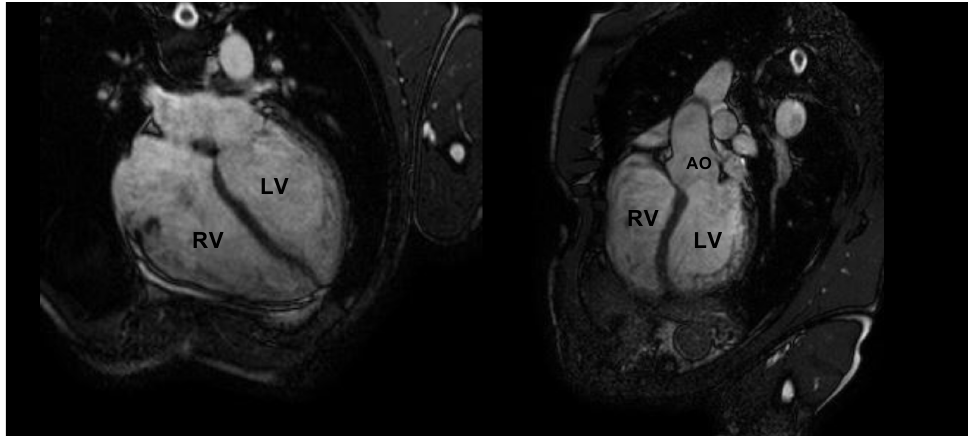
Figure 4. Cardiac magnetic resonance in an endurance athlete (long-distance swimmer). A symmetric dilatation of both right and left ventricular chambers is clearly depicted in 4-chamber (left panel) and 5-chamber (right panel) views. AO: aorta; LV: left ventricle; RV: right